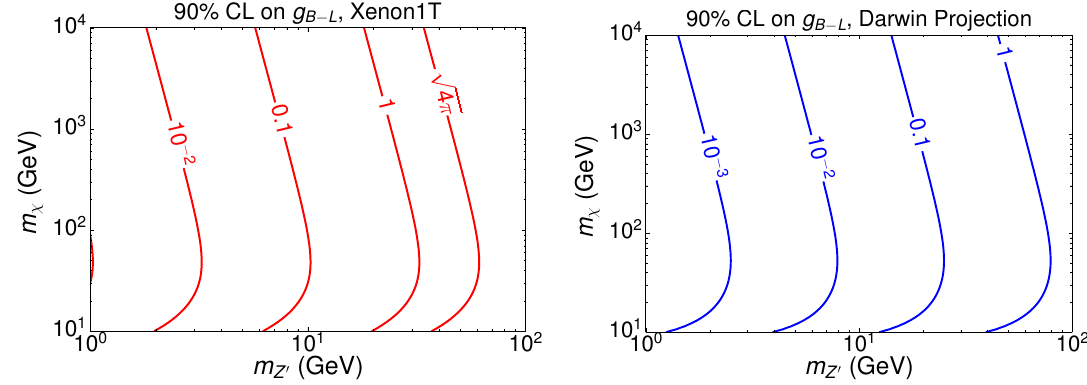
Figure 3 . Left: direct detection constraints from Xenon1T at the 90% CL. Right: projected sensitivity for Darwin assuming a 200 ton-year exposure and no observed